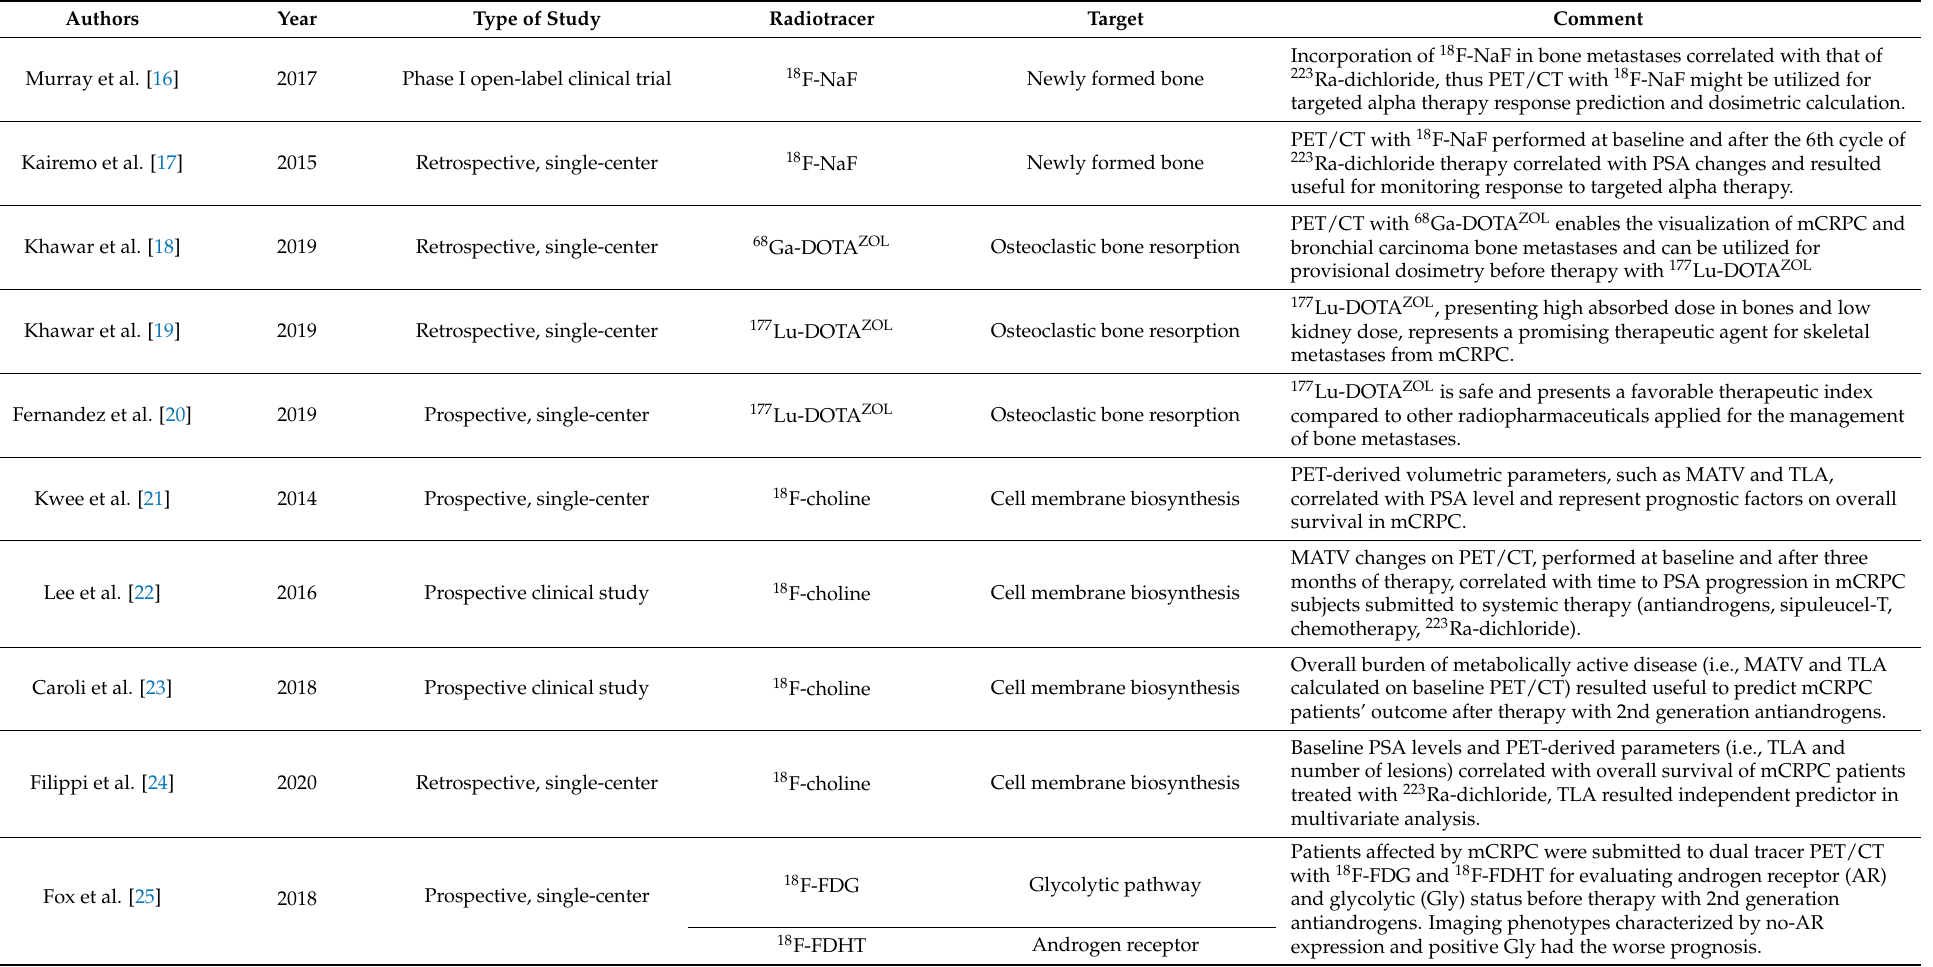
Table 1. Summary of the main manuscripts on the prognostic and theranostic applications of positron emission tomography (PET) tracers in